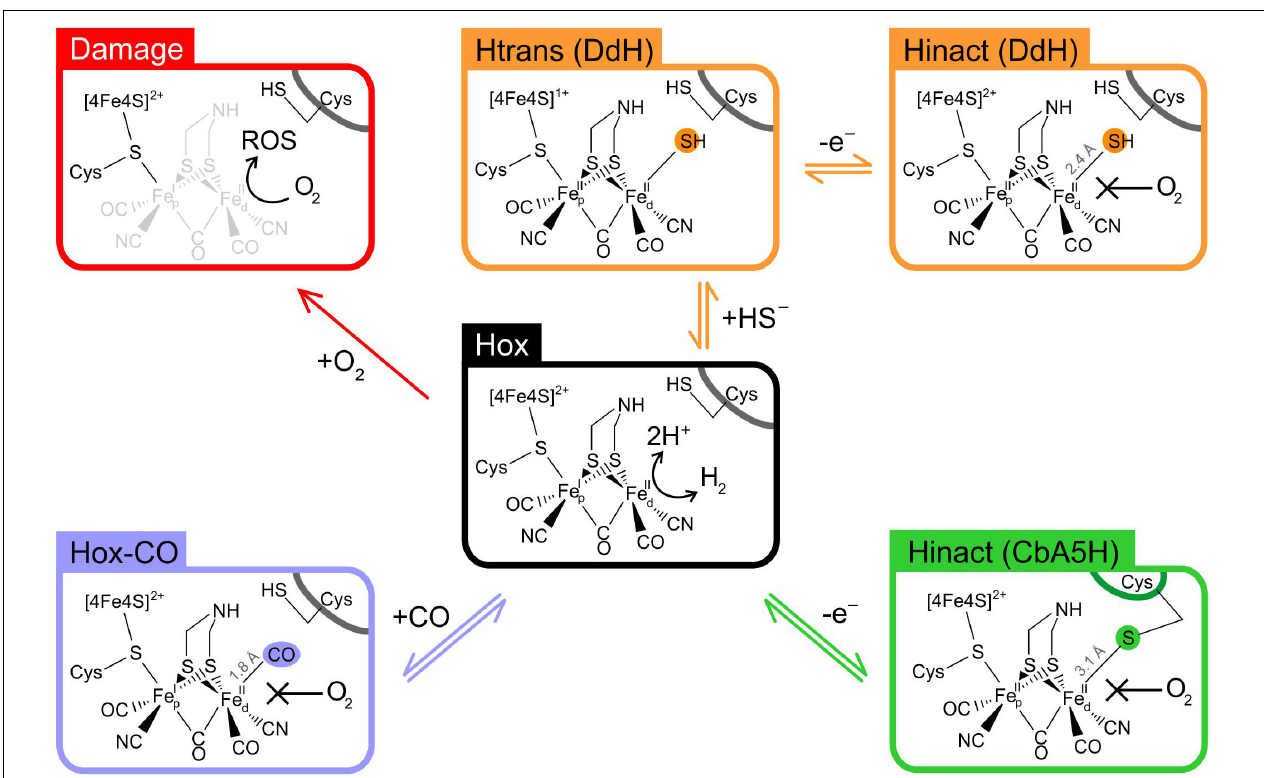
FIGURE 2 | Oxygen tolerance strategies in [FeFe]-hydrogenases. Schematic representation of the H-cluster in the oxidised active state Hox (centre). In the absence of any exogenous protectant, numerous [FeFe]-hydrogenases undergo irreversible inactivation due to H-cluster damage with loss of Fe atoms (red pathway); carbon monoxide acts as a protective agent due to its ability to form Hox-CO, by binding reversibly to the H-cluster at the same site as O 2 (purple pathway); in DdH, a similar mechanism occurs when sulphide binds to the H-cluster forming Hinact, via the Htrans intermediate (orange pathway); in CbA5H, a conformational change in the protein structure allows for a conserved cysteine to directly bind to the H-cluster, forming Hinact (green pathway). Fe p , proximal iron atom; Fe d , distal iron atom; Cys, cysteine